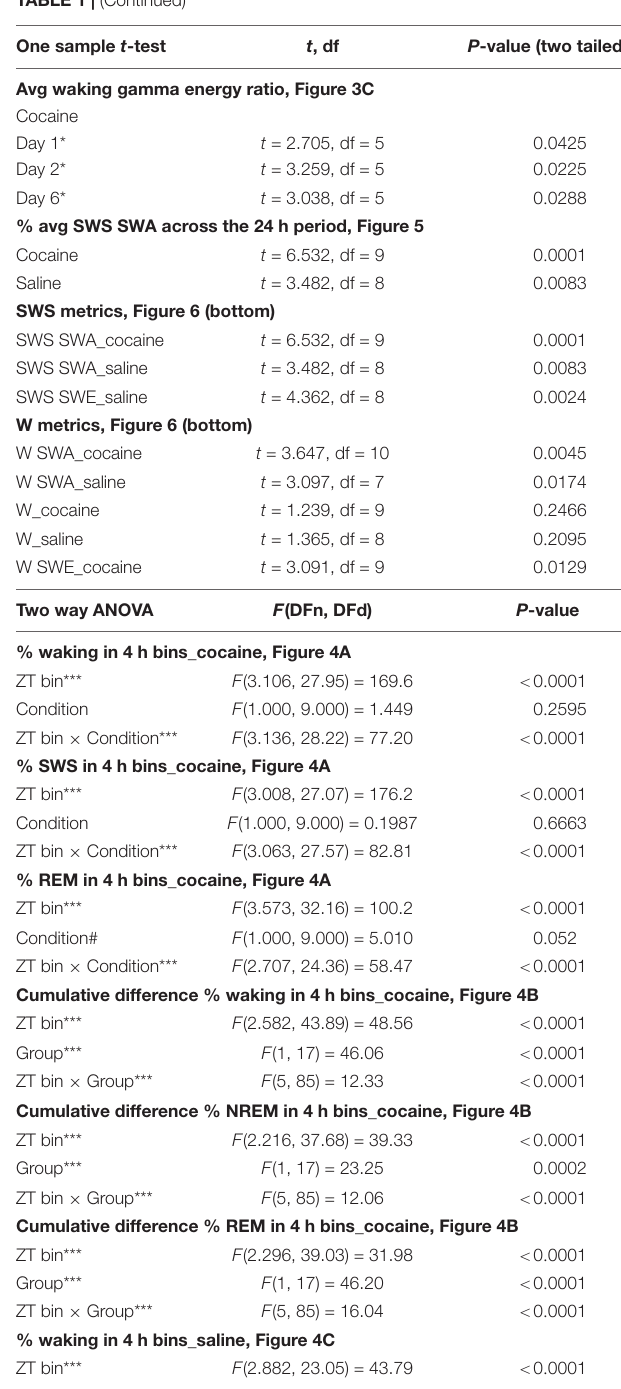
TABLE 1 | Table of P and F values for all main